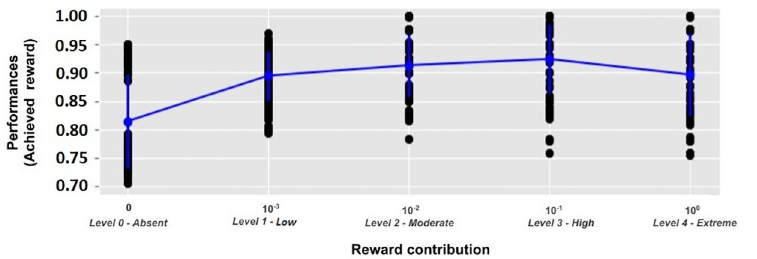
Fig 6. Performances (maximum reward obtained at the end of training) of models featuring different levels of RL contribution.